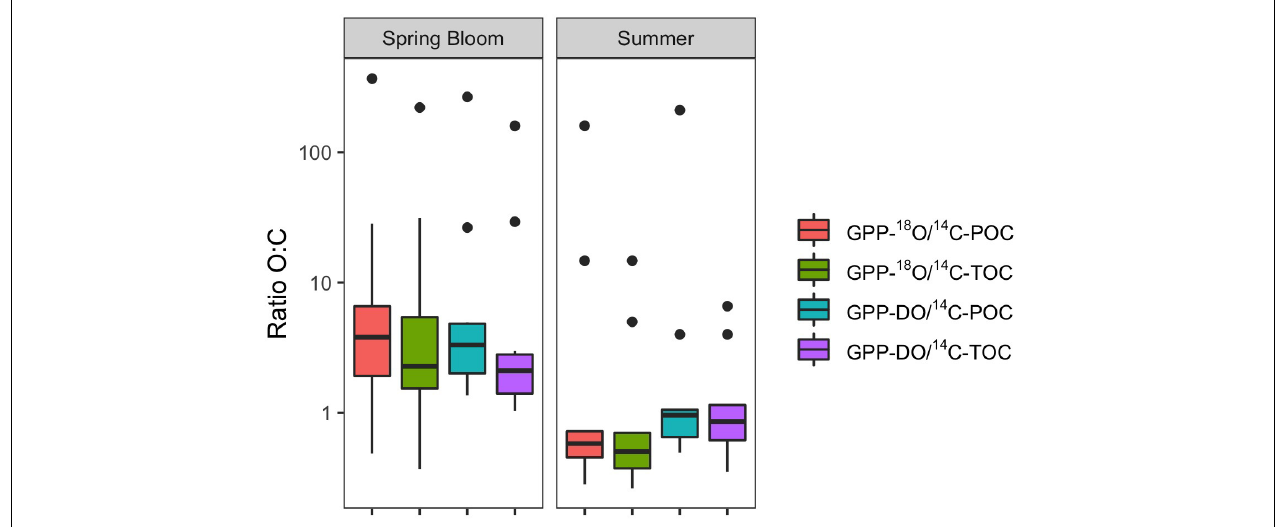
FIGURE 4 | Box plots of O:C ratios of PP estimates, by season (May – spring bloom n = 10; August – summer n = 9). Box plot showing the median (horizontal line), as well as the 25 and 75th percentiles, with vertical lines going to extremes, and outliers denoted by points.